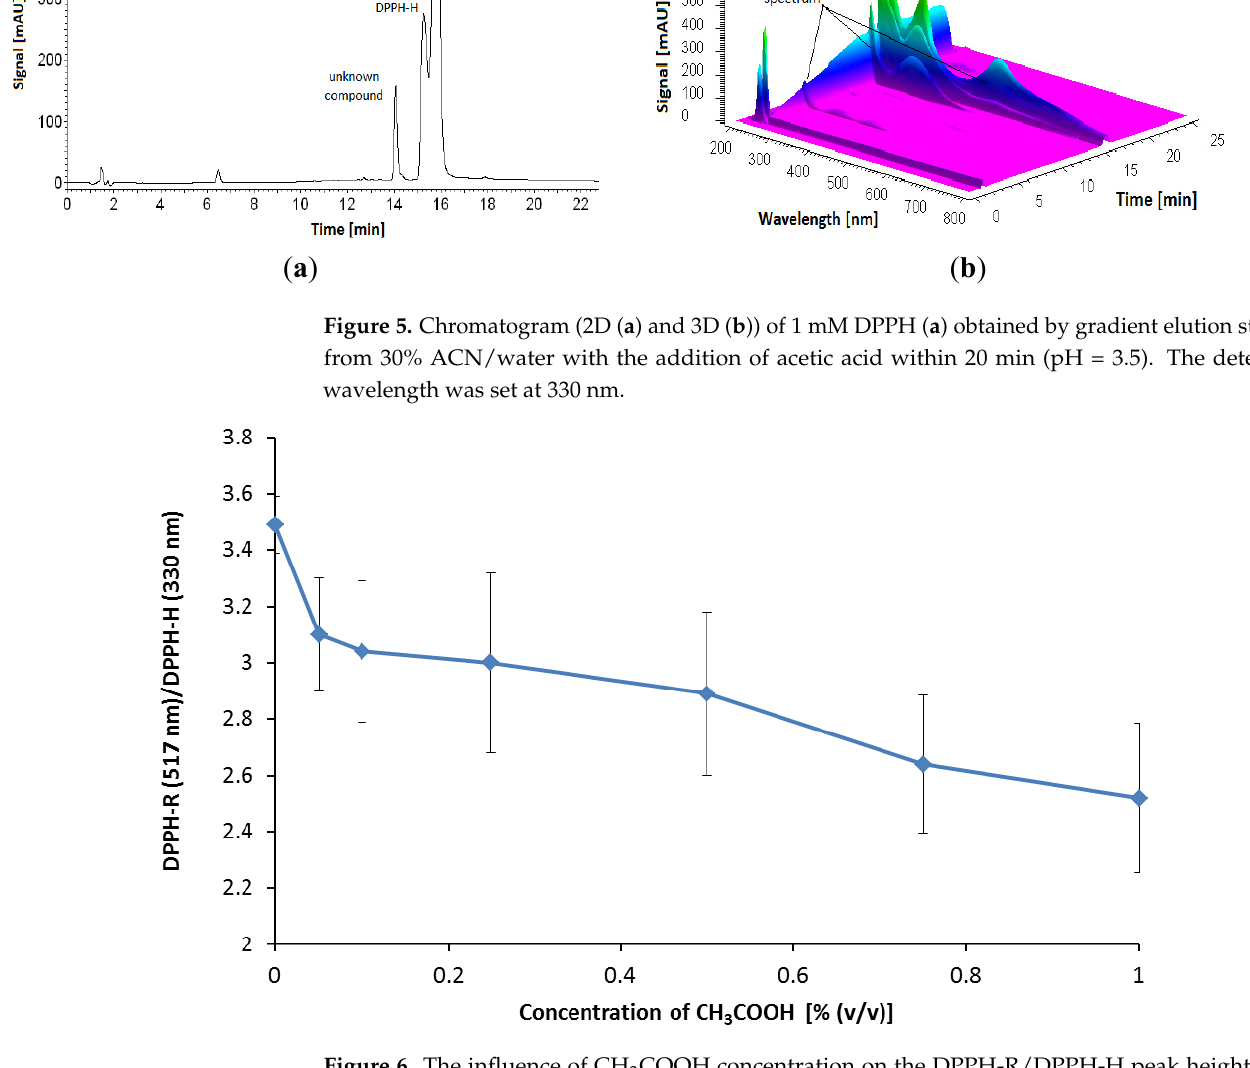
Figure 6. The influence of CH 3 COOH concentration on the DPPH-R/DPPH-H peak height ratio. Chromatographic conditions: gradient elution from 30% ACN to 60%ACN within 20 min and detection wavelengths of 330 nm (DPPH-H) and 517 nm (DPPH-R). The error bars indicating SD were calculated on the basis of three independent measurements.